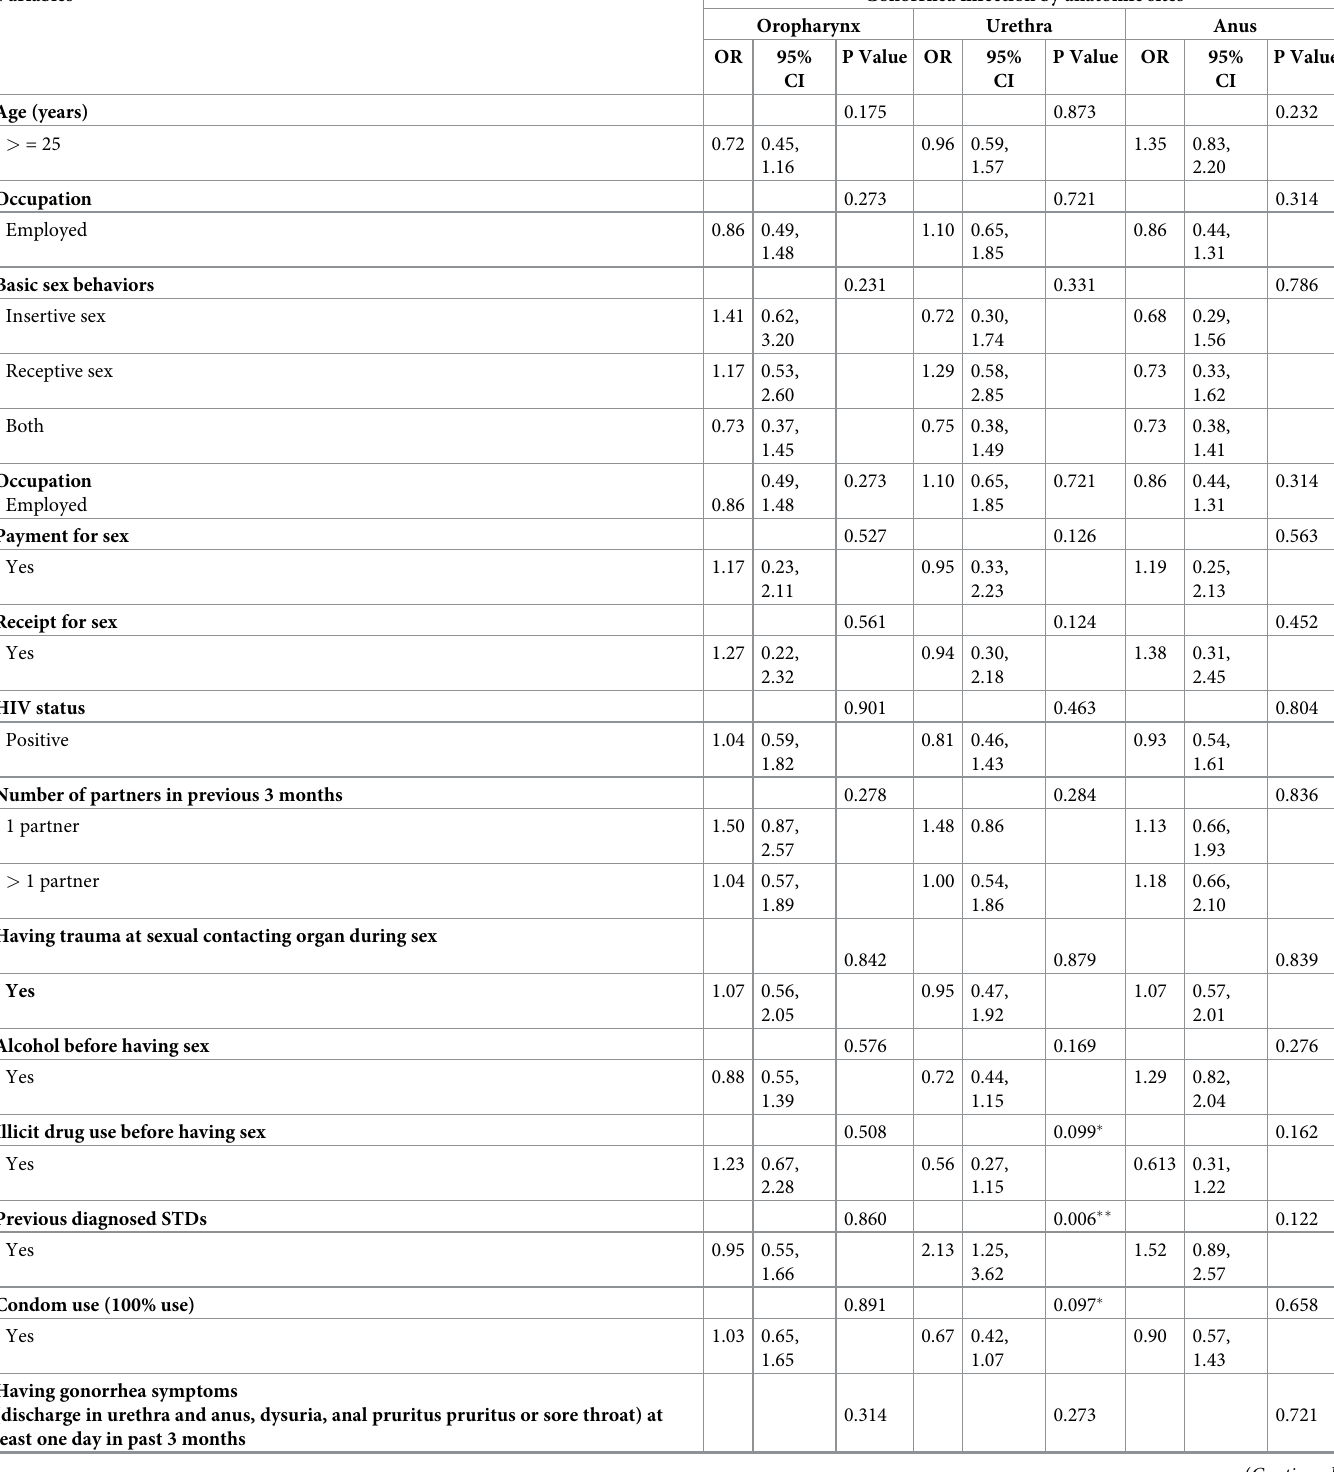
Table 3. Odds ratio for each selected factors associated with gonorrhea by anatomic distributions using univariate